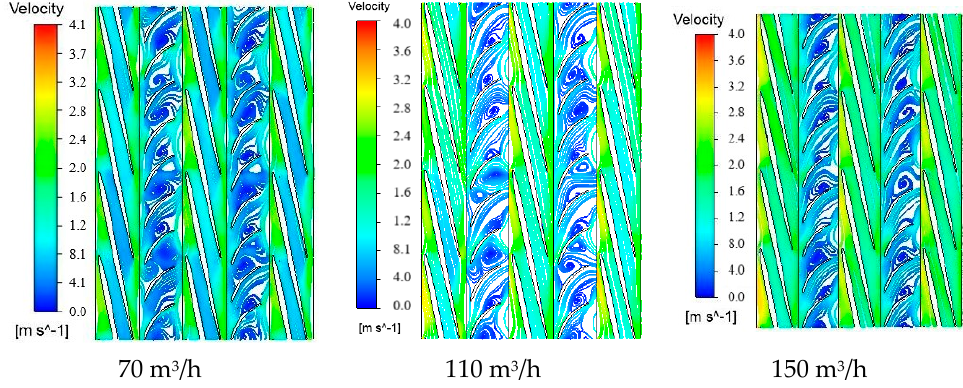
Figure 10. The streamline distribution at 0.5 blade height of multiphase pump pressurizing units.